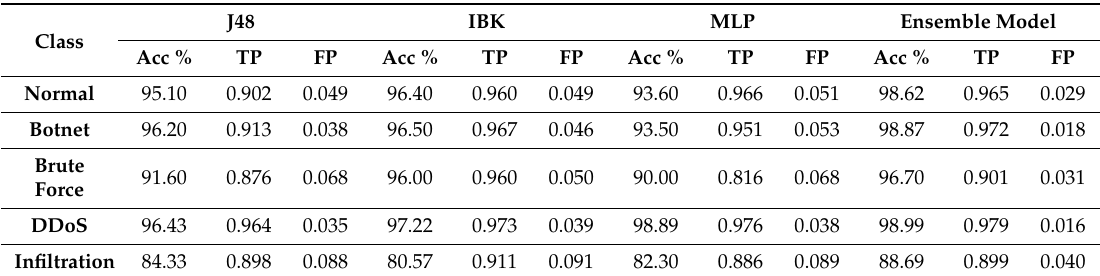
Table 7. Individual and ensemble